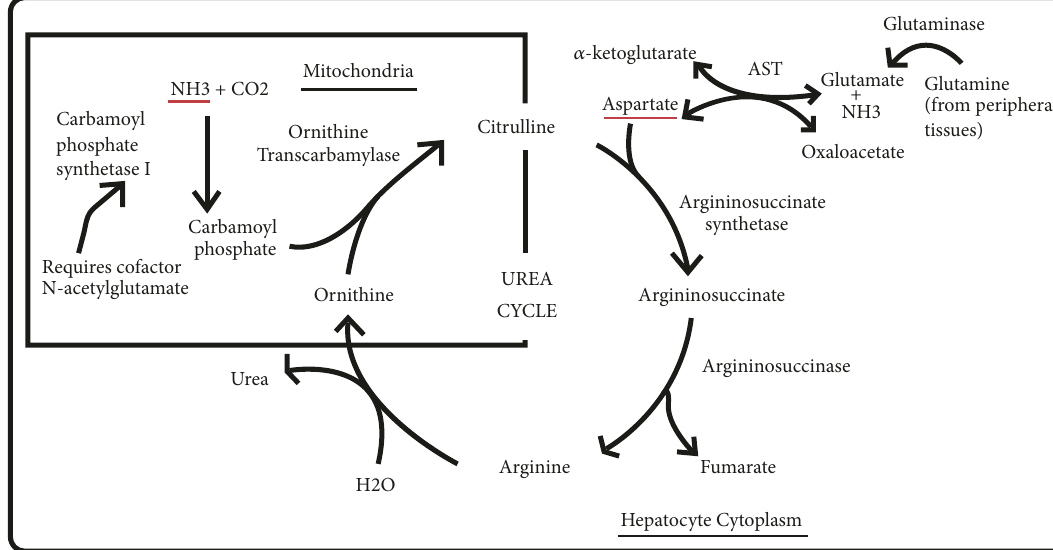
Figure1:Ureacycle.Ammoniaisthesourceofthefirstaminogroupintheureacycle,requiredinthesynthesisofcarbamoylphosphate(CPS), whichhappens in the hepatocytemitochondria. The second amino group comes from glutamatein the formation of aspartate,whichhappens in the hepatocyte cytoplasm. This reaction produces 𝛼 -ketoglutarate, which then becomes available for the Krebs cycle. The synthesis of argininosuccinatelinks the Krebs cycle and urea cycle. In the peripheral tissues, glutamateaccepts free ammonia from amino acid catabolism. Glutamine transports ammonia from the peripheral tissues to the liver, where glutamine is broken back to glutamate and ammonia via glutaminase. AST, aspartate